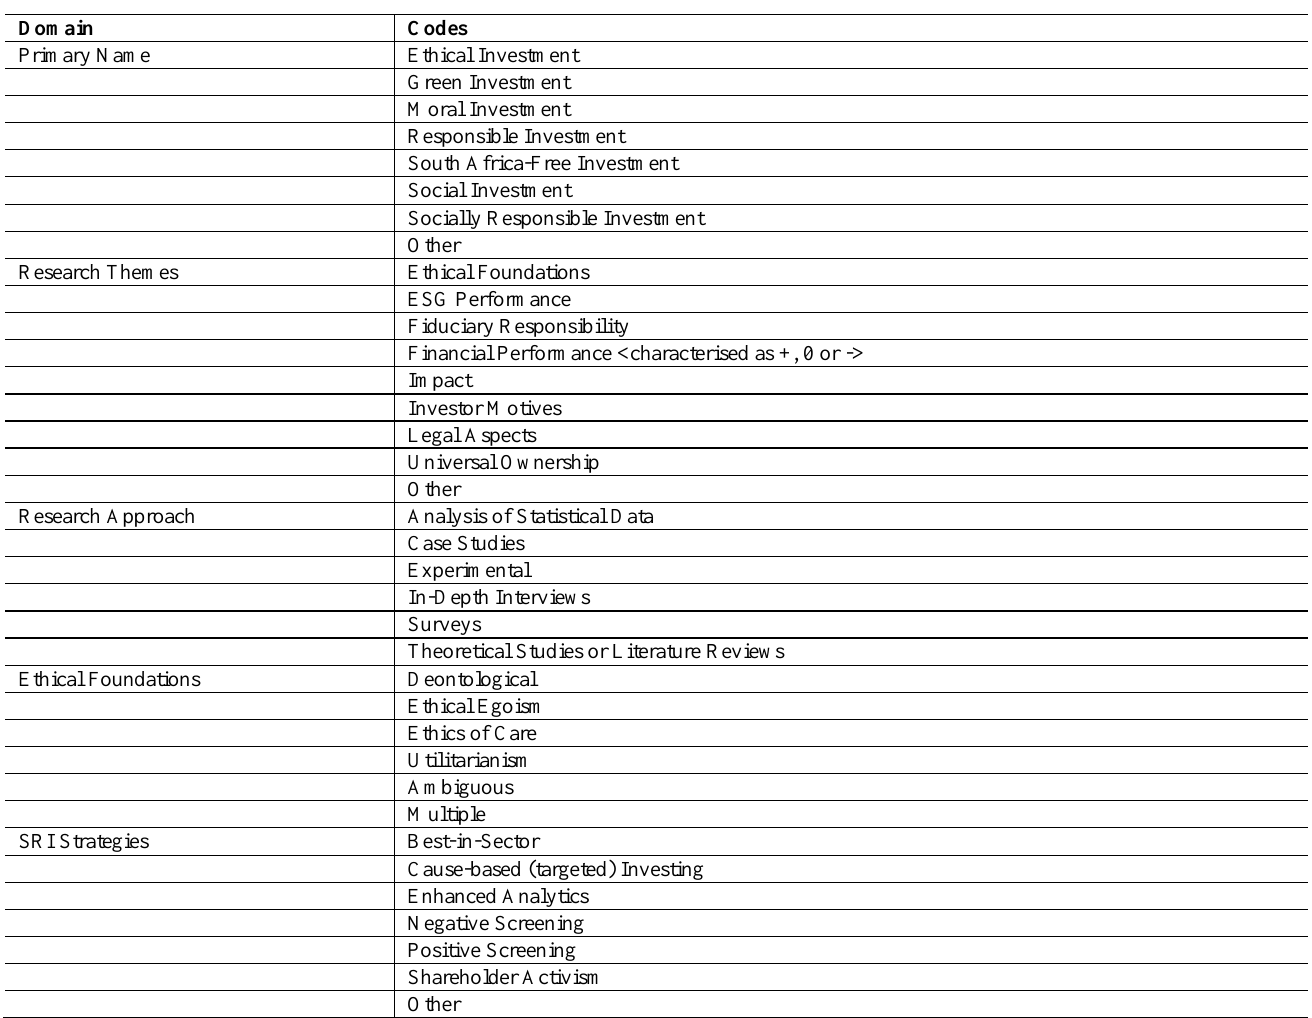
Table 1: Domains used to characterise papers in the sample